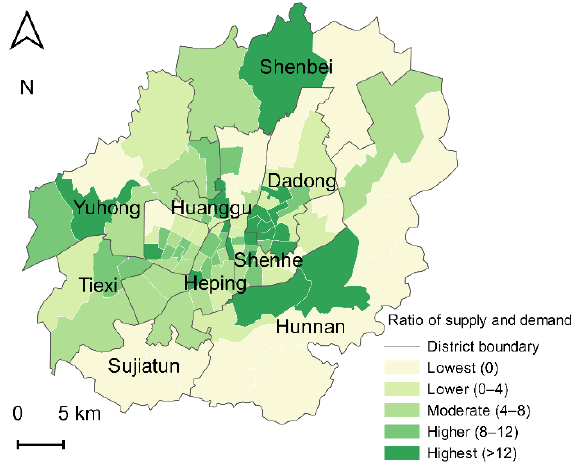
Figure 3. Spatial distribution of supply–demand to healthcare services in the main urban area of Shenyang.